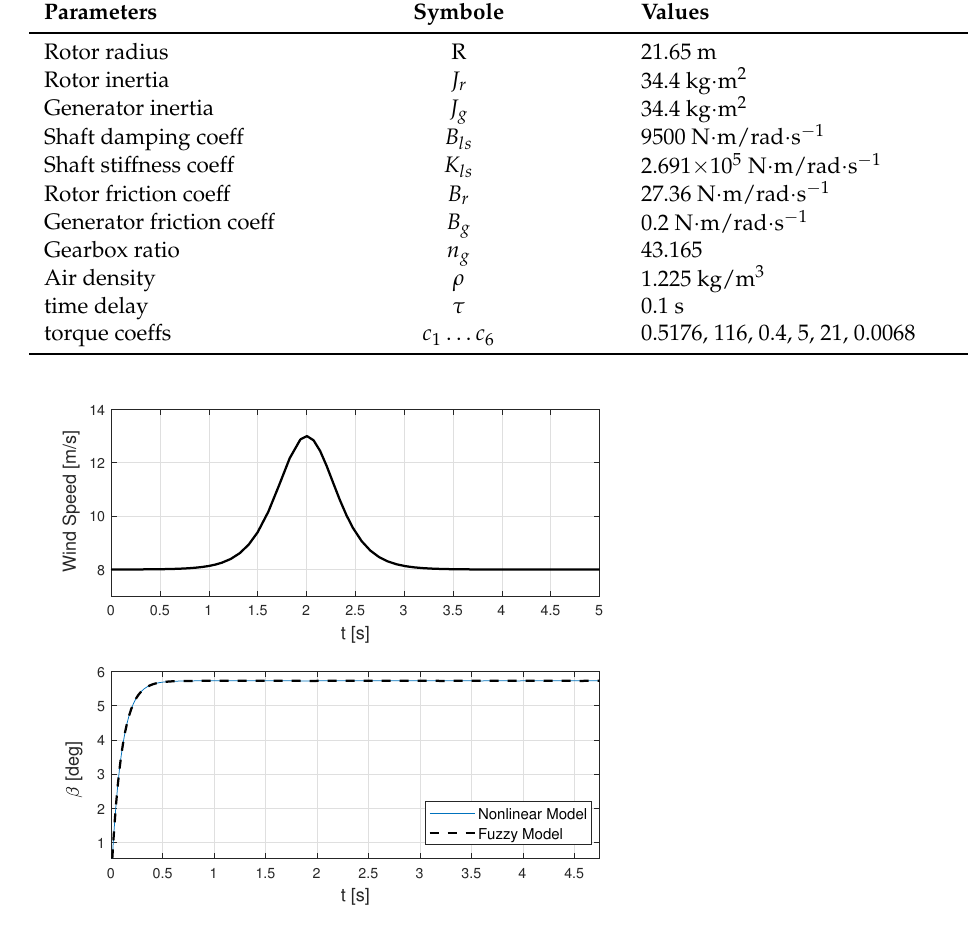
Figure 4. Wind speed and blade pitch angle.